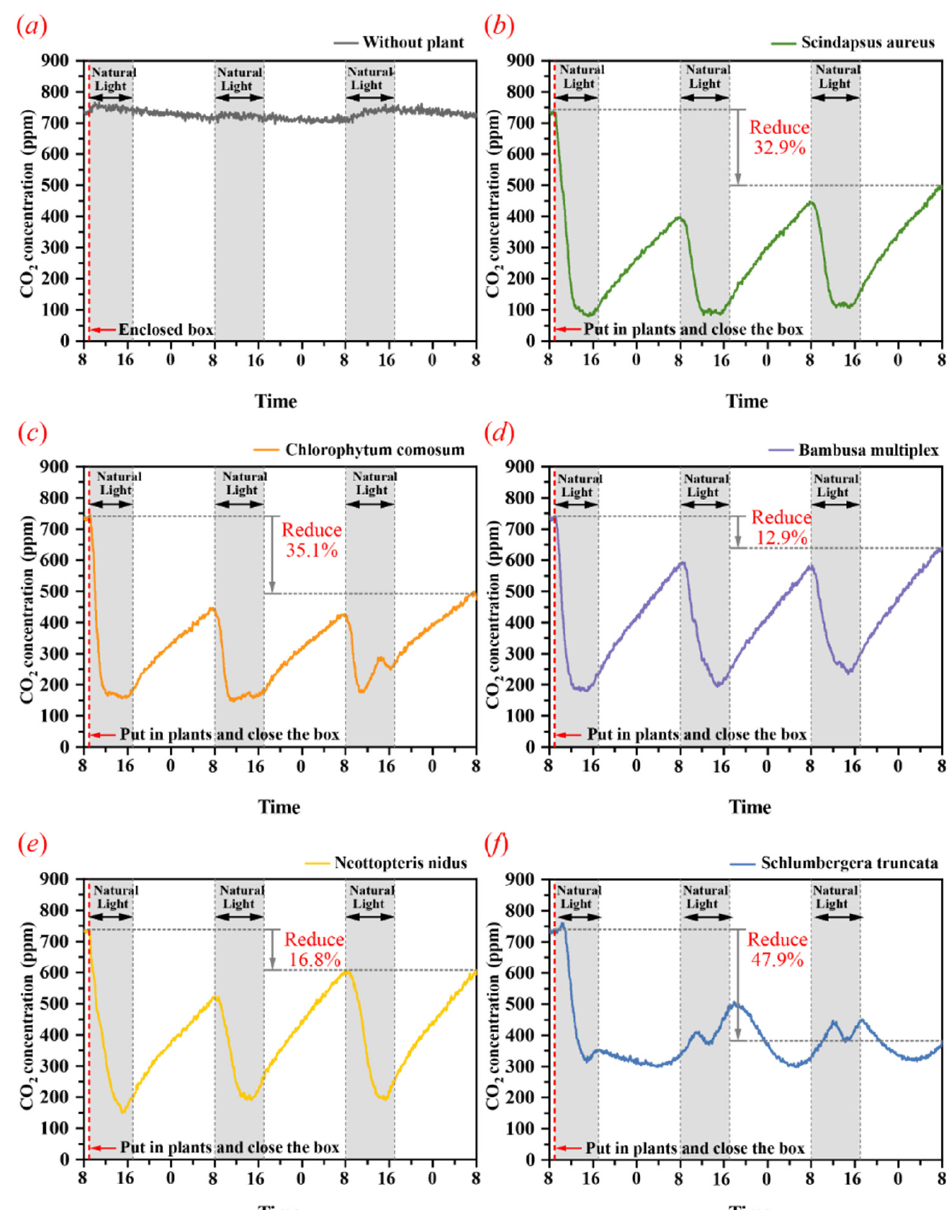
Figure 3. Fluctuation of CO 2 concentration in six sealed chambers in the natural lighting environment. ( a ) without plant ( b ) Scindapsus aureus ( c ) Chlorophytum comosum ( d ) Bambusa multiplex ( e ) Neottopteris nidus and ( f ) Schlumbergera truncate .